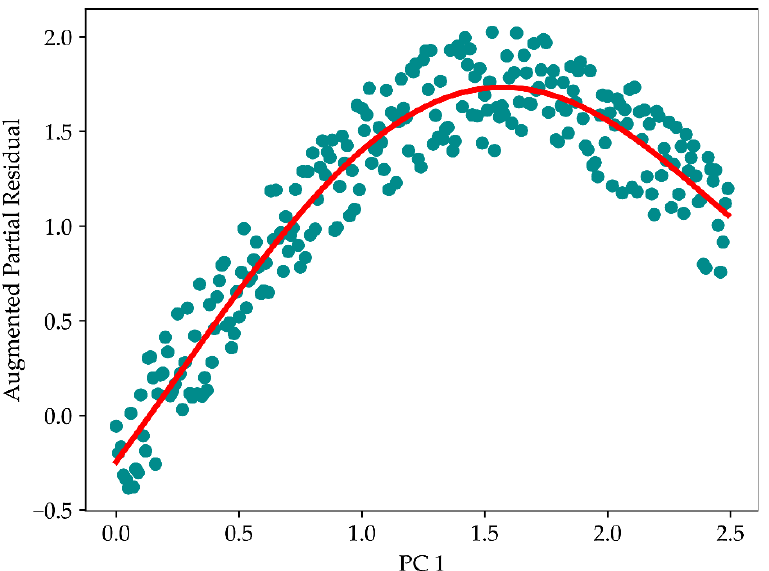
Figure 4. Determining nonlinearity in LIBS dataset using an augmented partial residual plot towards , where the first twelve s were included in the calculation and plotting.